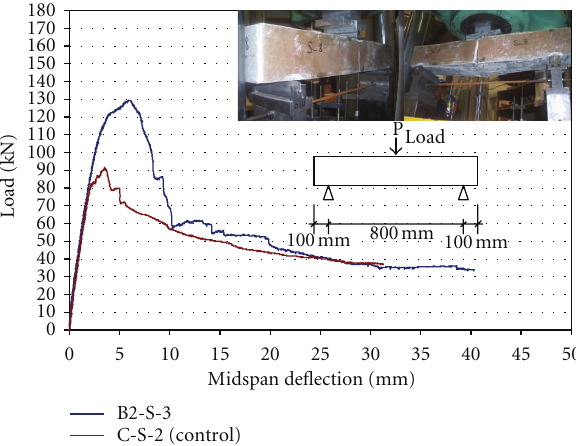
Figure 16: Load versus midspan deflection of RC beam B2-S-1.